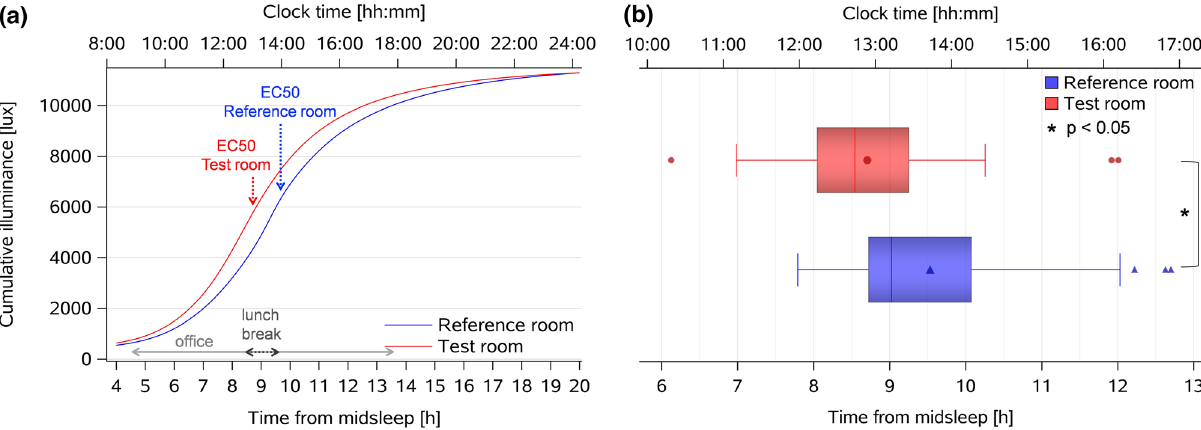
Figure 3. Dose–response curves for accumulated individual illuminance (E v ) from wearable light sensors and half-maximum responses (EC50). ( a ) Dose–response curves for accumulated individual vertical illuminance (E v ) from wearable light sensors, aligned to elapsed time since habitual midsleep (lower x-axis) and corresponding clock time (upper x-axis); vertical arrows indicate the half-maximum response times [EC50; mean = 8:42 (h:mm) since habitual midsleep in the Test room (red; n = 30), and 9:32 since habitual midsleep in the Reference room (blue, n = 33)]; the horizontal arrows show the time in the offices and the lunch break spent outside the office. ( b ) Box plots for half-maximum response times of individually accumulated illuminance (E v ). The box plots show mean (red and blue symbols inside the boxes), median (red and blue vertical lines), minimum and maximum values (red and blue horizontal bars), outliers (symbols outside the and bedtimes; p > 0.5). It was 650 ± 1132 lux (mean ± SD) for the Test room and 675 ± 1351 lux for the Reference room (Table 1). From visual inspection however, it appeared that there may be illuminance differences between both room conditions only in the first half of the day. Thus, we analyzed individual E v from 5 to 9 h after midsleep (i.e., between the time of arrival in the office to lunch time). The results indeed showed significantly higher individual photopic E v in the Test (1231 ± 1665 lux) than in the Reference room (973 ± 1300 lux; main effect of condition : F 1,289 = 10.1, p = 0.002), with a variation over time (main effect of time : F 4,267 = 38.2, p < 0.0001), but no significant interaction between both factors ( p > 0.5). When the same analysis was carried-out with the photopic E v for the second half of the day (i.e., after 10 h since midsleep until bedtime), there was no main effect of condition ( p > 0.1). In the next step we computed the accumulated photopic E v in both conditions by applying non-linear curve fitting on individual curves to evaluate whether the timing of accumulated E v was different between both condi- tions (see “Methods”). The results from the individually fitted curves confirmed that the half-maximum response (EC50) of accumulated E v occurred significantly earlier in the Test room than in the Reference room i.e., at 8:42 ± 1:16 versus 9:32 ± 1:22 (h:mm) since midsleep (main effect of condition: F 1,33 = 5.4, p = 0.027; Fig. 3a,b) corresponding to clock times 12:57 and 13:35 (please note that clock time differences slightly deviate due to the non-significant average clock time differences of 12 min between the Test and the Reference room condition, see Table 2(a) and “Methods”). The accumulated E v at EC50 was on average 5950 photopic lux in the Test room , which corresponds to ~ 4800 lux melanopic EDI. Melatonin and cortisol. Melatonin. Salivary melatonin secretion profiles during habitual waketime were averaged across two days (see also below) and per room condition and exhibited a typical time course (supple- mentary Figure S5a; main effect of time : F 10,565 = 123.2, p < 0.0001), with no significant concentration differences between both conditions ( p > 0.1). Melatonin onsets at home (defined as time when salivary melatonin concentrations exceeded a threshold of 3 pg/ml, see “Methods”) were not statistically different between the first and the second day of salivary collec- tions ( p > 0.5) and therefore, all melatonin analyses were performed on averaged melatonin secretion profiles per